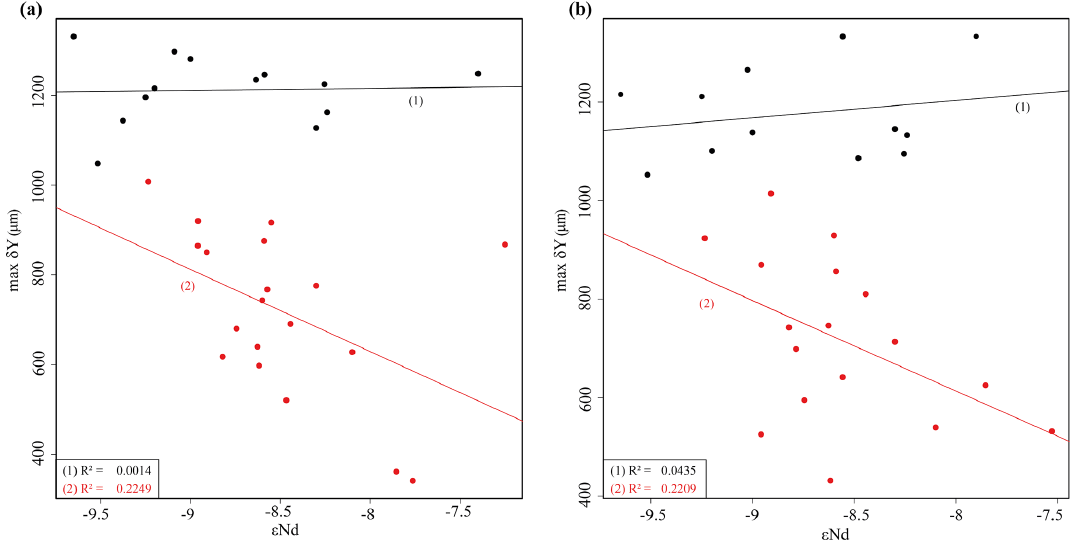
Figure A8. Linearly interpolated ε Nd values derived from Dausmann et al. (2017) plotted versus the maximum axial length ( δY ) of G. menardii from 33 sediment samples from Hole 667A and 29 samples from Hole 925B. The samples have an age of up to 8Ma (Ta- ble 1, this study; Knappertsbusch 2016, respectively). (a) Correlation between ε Nd and δY for all samples of Hole 667A. Black points represent samples with an age between 0 and 2Ma and red dots samples with an age between 2 and 8Ma. The black line (1) is the coefficient of determination ( R 2 ) for samples with an age of 0–2Ma and the red one (2) for samples from 2 to 8Ma. (b) Correlation between ε Nd and δY for samples of Hole 925B. Red dots represent samples from time intervals 8 to 2Ma. The bottom-left corner shows the corresponding R 2 and p